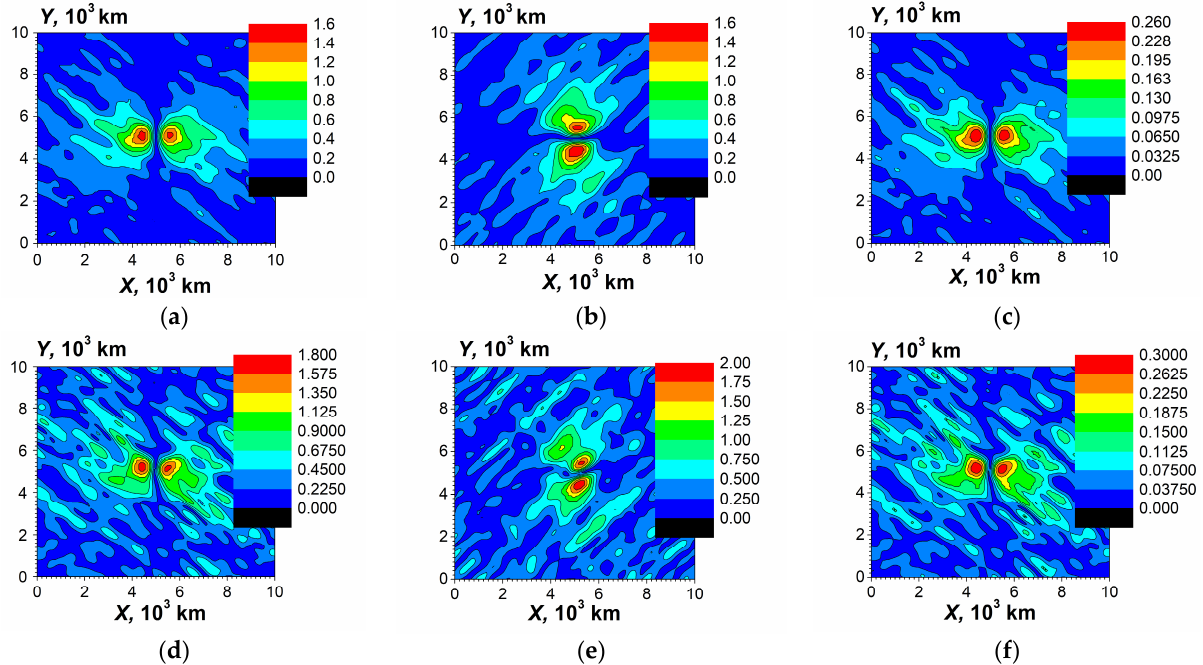
Figure 6. Distributions of the electric field components (in mV/m) in the ionosphere F- layer at the height z = 200 km, the dynamic simulations. The case of open geomagnetic field lines is considered here. The frequencies are ω = 0.05 s -1 , parts ( a – c ), and ω = 0.025 s -1 , parts ( d – f ). Parts ( a , d ) are |E x (x,y)| , ( b , e ) are |E y (x,y)| , ( c , f ) are |E z (x,y)| . The total vertical distance of the simulation is L z = 1500 km. The geomagnetic field inclination is θ i = 10°.